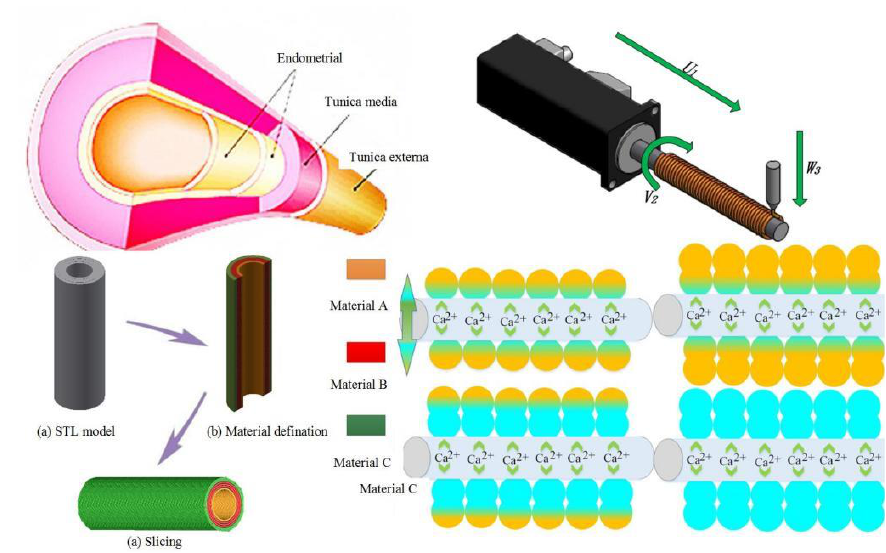
Figure 1. Vascular structure and multi-material vascular structure forming process.